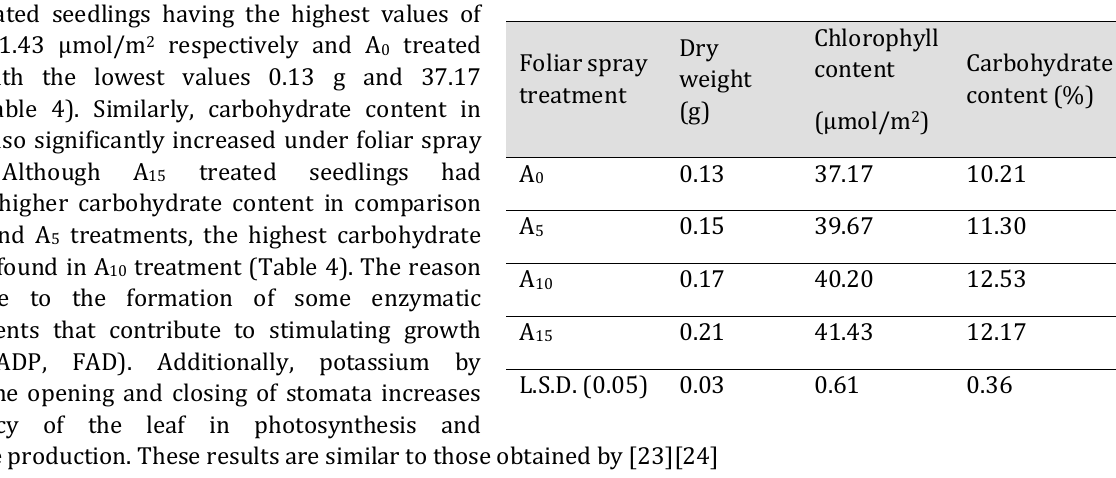
Table 4. Effect of foliar fertilization on biochemical characteristics of pear